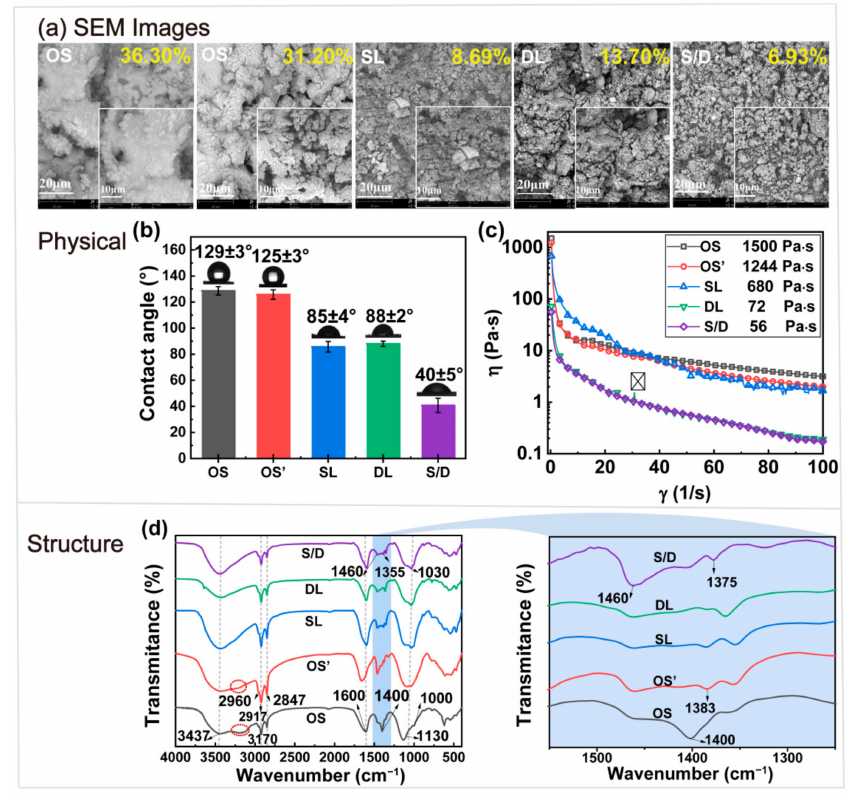
Figure 3. Effect of different treatment methods on physical and chemical characteristics of oily sludge (OS) (( a ), SEM of OS; ( b ), Contact angle of OS; ( c ), OS viscosity; ( d ), FITR of